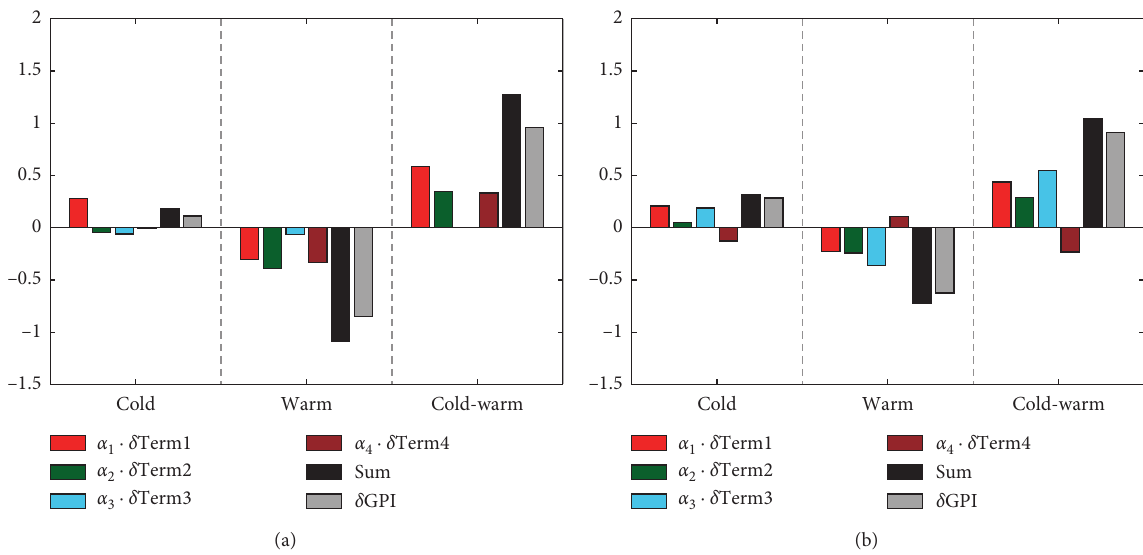
Figure 7: Relative contributions to (a) δ GPI the observed δ